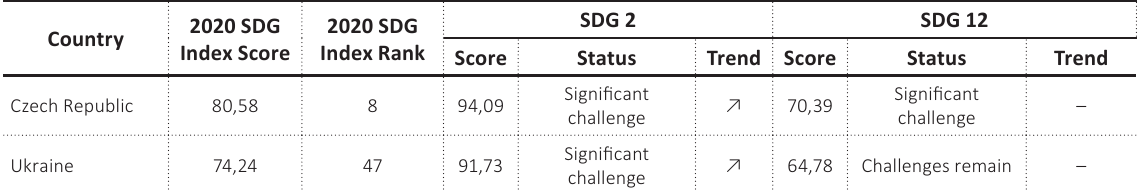
Table 4. Assessment of progress in achieving the targets of SDGs 2 and 12 in Ukraine and the Czech Republic according to global